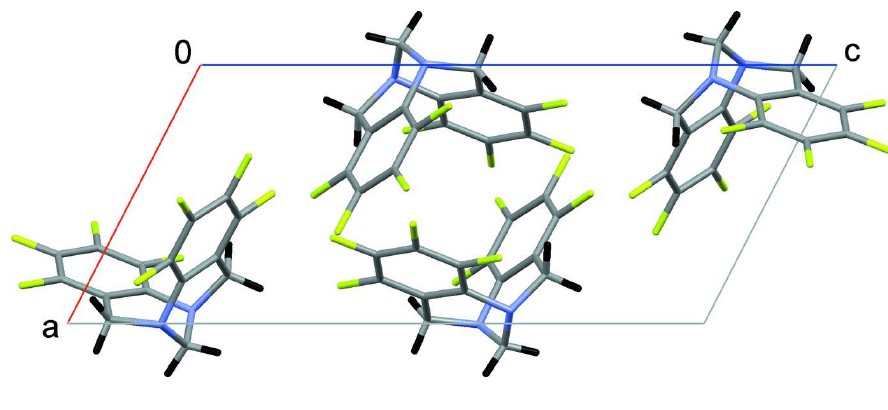
Figure 2 View of the unit cell down the b